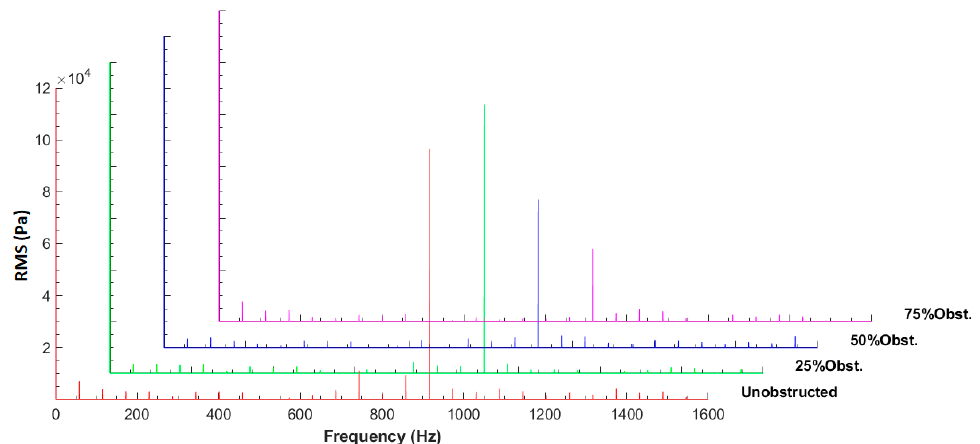
Figure 15. Frequency spectra in the rotating reference frame (monitor point R1) for different rotor blockage sizes.